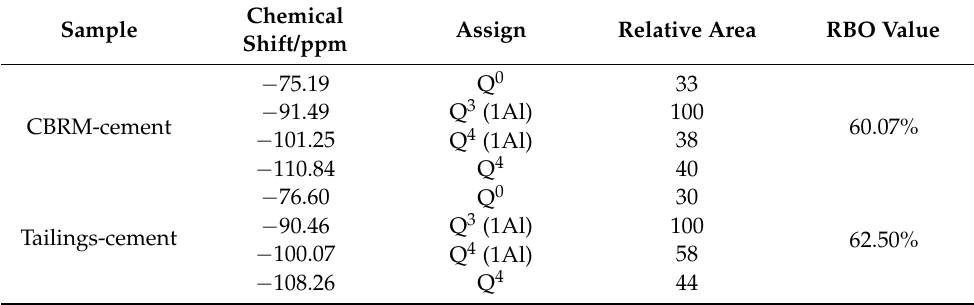
Table 8. The SiQ n and RBO of CBRM-cement and